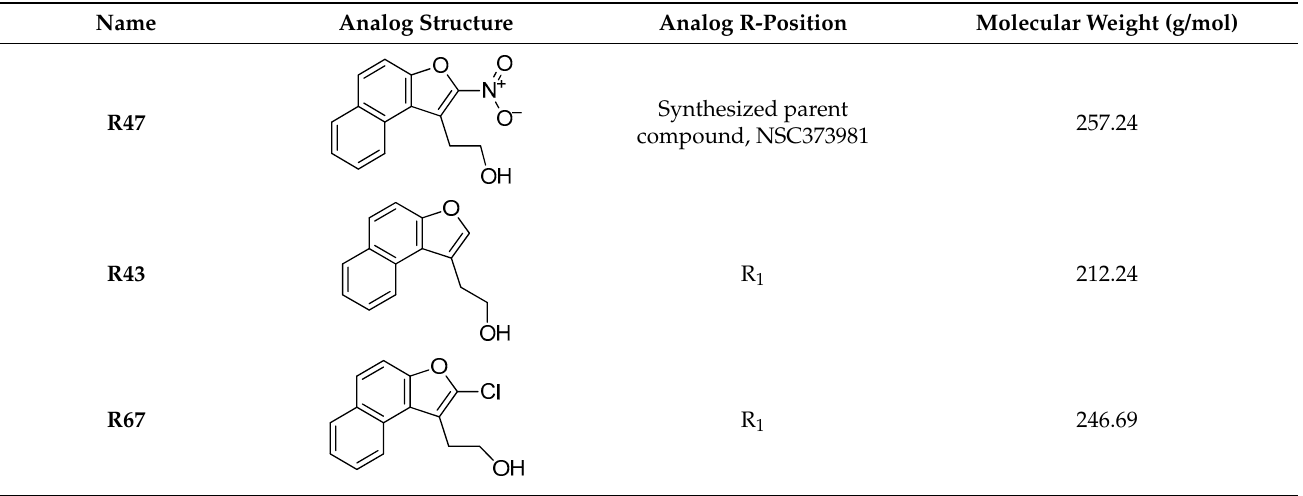
Table 1. Chemical structure and molecular weight of NSC373981 analogs.